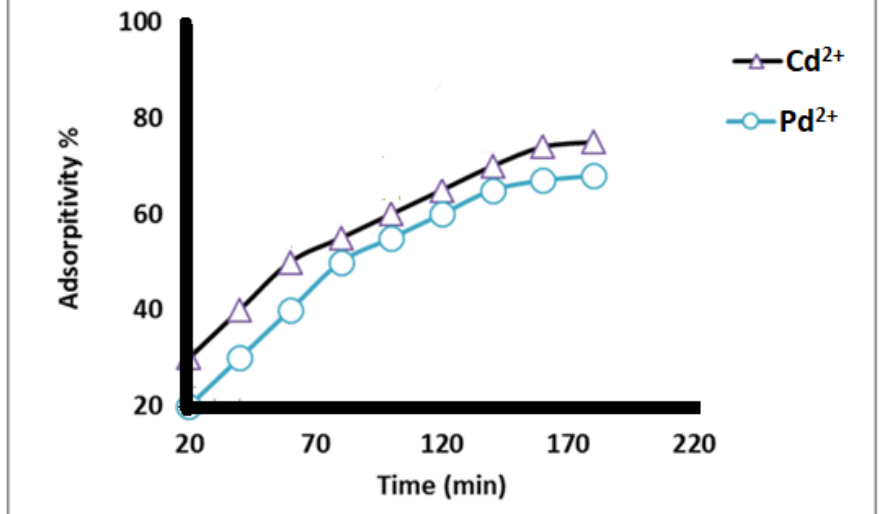
Figure 7. Adsorption percent of different heavy metal ions at different contact time (min) using 50 mg/L metal ion concentrations at pH 5. 50 mg/L metal ion concentrations at pH 5.